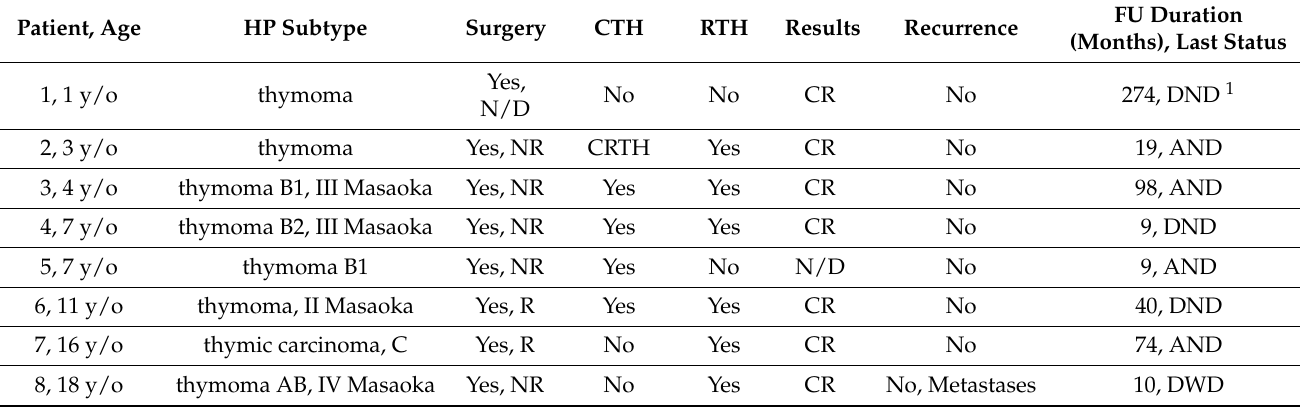
Table 3. Characteristics of the treatment in particular patients.